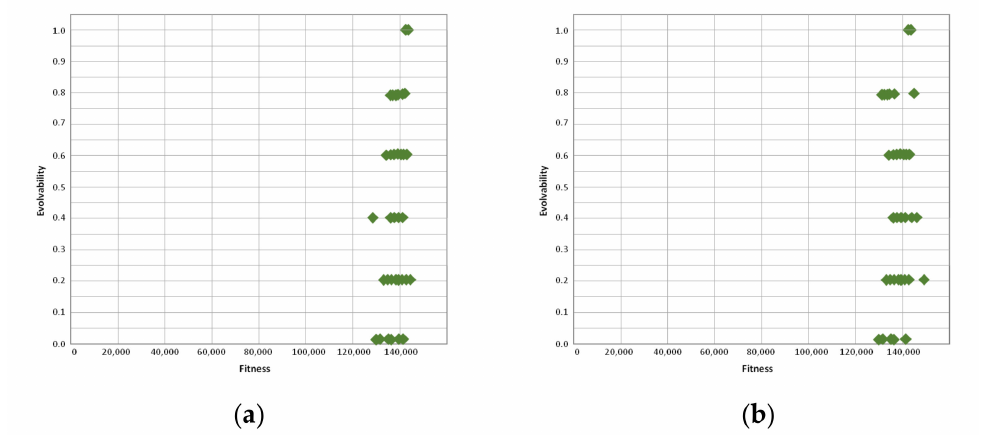
Figure 20. The evolvability in case of 2-opt ( a ) and order crossover operator ( b ).